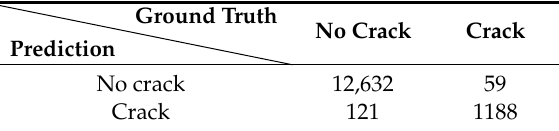
Table 3. Crack detection results